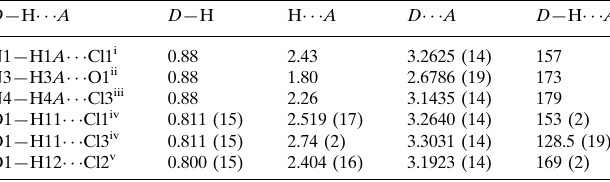
Hydrogen-bond geometry (A˚ , (cid:2)